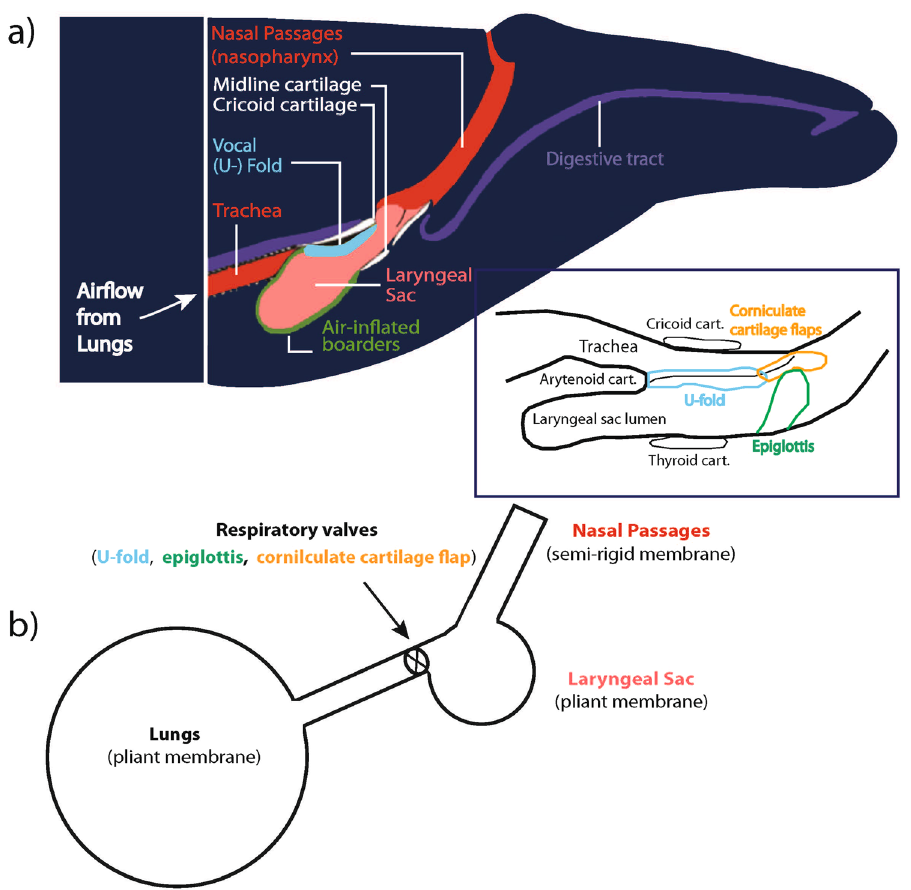
Figure 2. Schematic diagrams showing ( a ) generalized upper respiratory structures in a baleen whale (after Reidenberg and Laitman 19 ), with specific location and relative position of respiratory valves (after Cazau et al . 29 ) in the attached insert. (reproduction permissions granted by John Wiley & Sons, Inc. and AIP Publishing LLC) and ( b ) simplified sound source model based on structures in ( a ) (after Aroyan et al . 18 ; permission granted by Springer publishing), ( a ) Red area shows upper respiratory tract including nasal passages and trachea; purple shows the digestive tract; pink shows the laryngeal sac or lumen; green shows the air inflated borders of laryngeal sac; white shows midline, cricoid and thyroid cartilages; light blue shows the vocal or U-fold; the insert shows the position, relative to the U-fold, of the two other respiratory valves present in the laryngeal region (epiglottis and corniculate cartilage 29 ) that also contribute to controlling airflow. Sound is thought to be produced by airflow from the lungs, through the oscillating, respiratory valves (the U-fold) then flow through the laryngeal sac and nasal passages. In the pulse model proposed here, repeated rapid adduction and dorsal elevation of the U-fold vocal process, against the cricoid cartilage, causes pulsed (restriction and release) airflow from the trachea to upper respiratory structures. Sound production likely originates by combining valve states and air recirculation by the lungs and the laryngeal sac through two opposite functions. The U-fold edges and laryngeal sac walls may also vibrate with airflow, potentially amplifying pulses. Laryngeal sac pulsed inflations may also cause pulsed distention of ventral throat grooves, facilitating sound transfer into